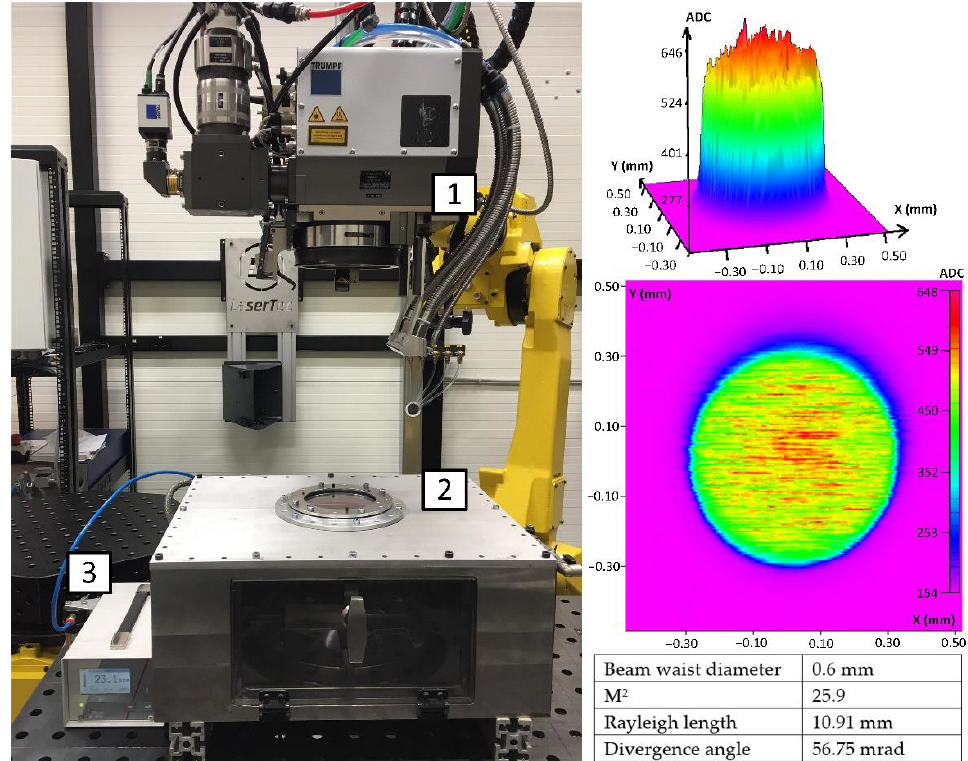
Figure 2. Experimental set-up utilized for the LP, 1-scanning laser head, 2-argon chamber, 3-oxygen analyzer ( left ). Beam intensity distribution in the focal plane and beam parameters ( right ).